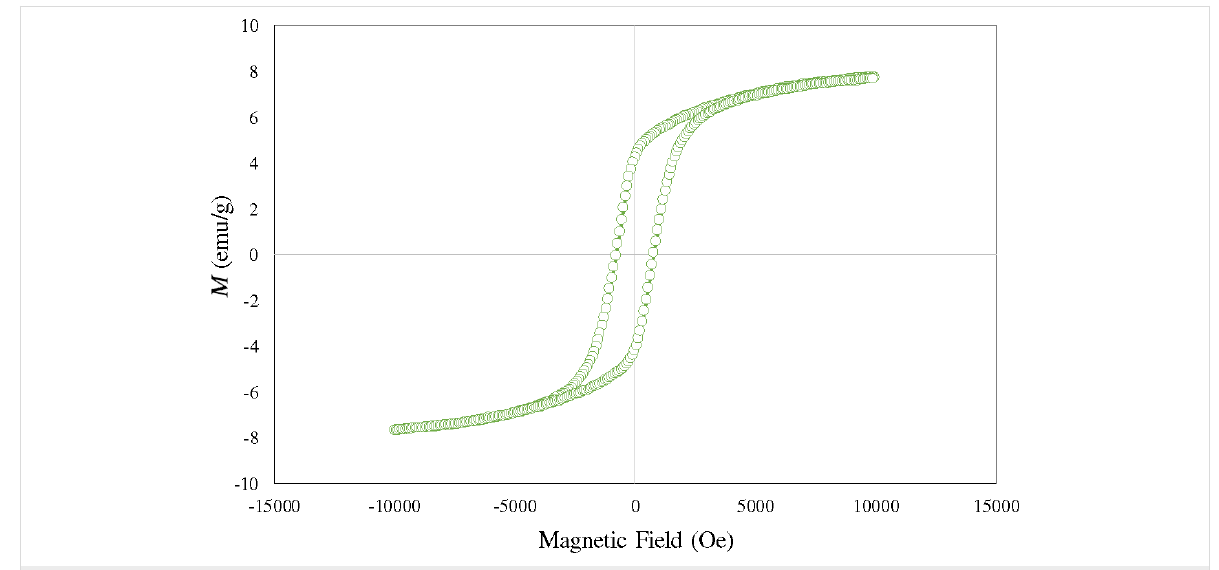
Figure 5: Vibrating sample magnetometer spectrum of 30 wt % CuFe 2 O 4 /HYPS.